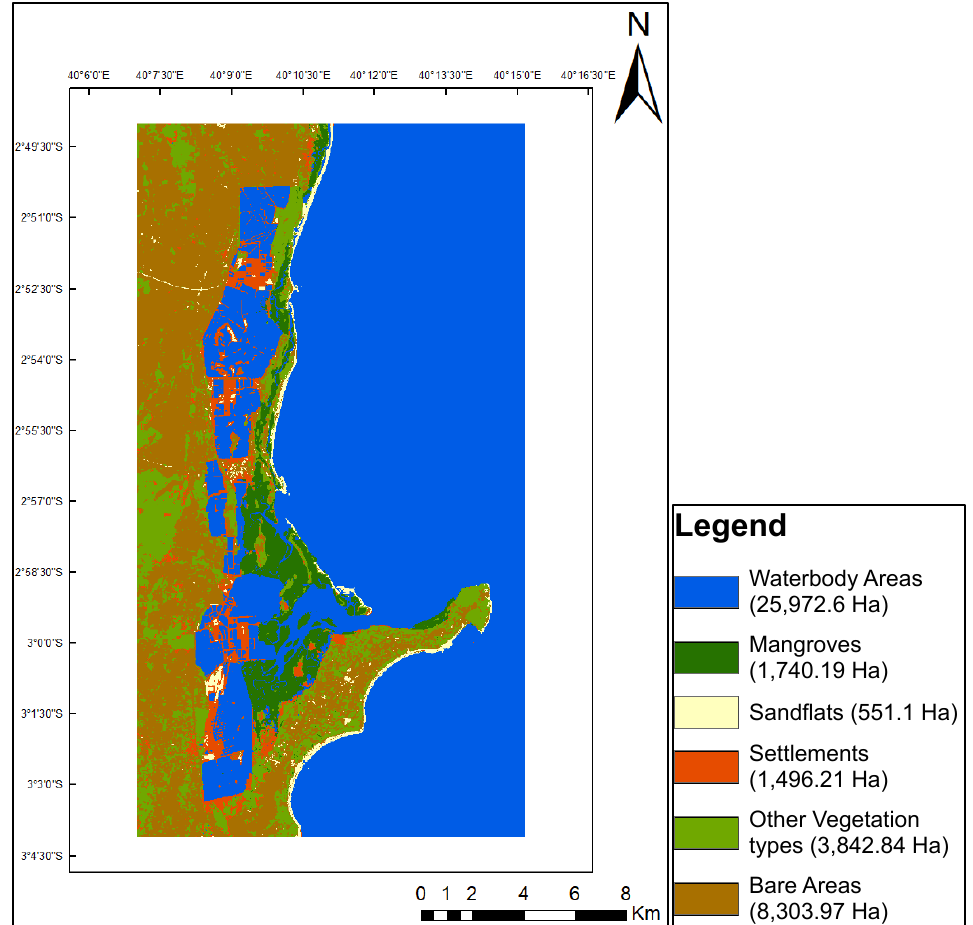
Figure 3. LULC classes and the area (Ha) of each class present in Ngomeni (Ungwana bay, Kenya) were processed using Sentinel-2 satellite image sensed in February 2021.